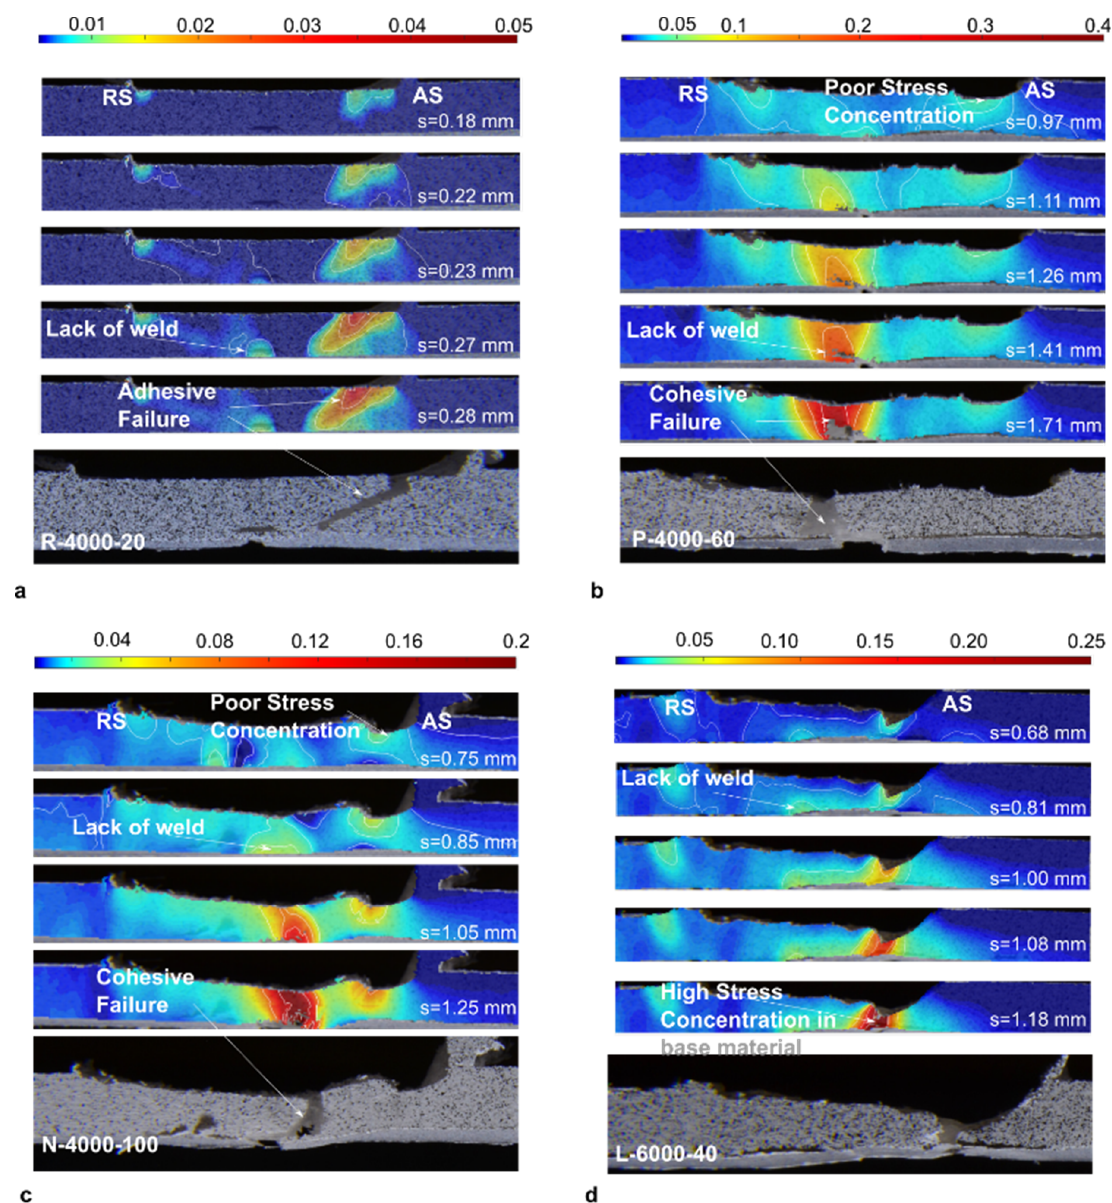
Figure 10. Failure modes and relative strain maps determined by means of DIC analysis [34]. ( a ) Adhesive failure; ( b , c ) cohesive failures and ( d ) stress concentration.